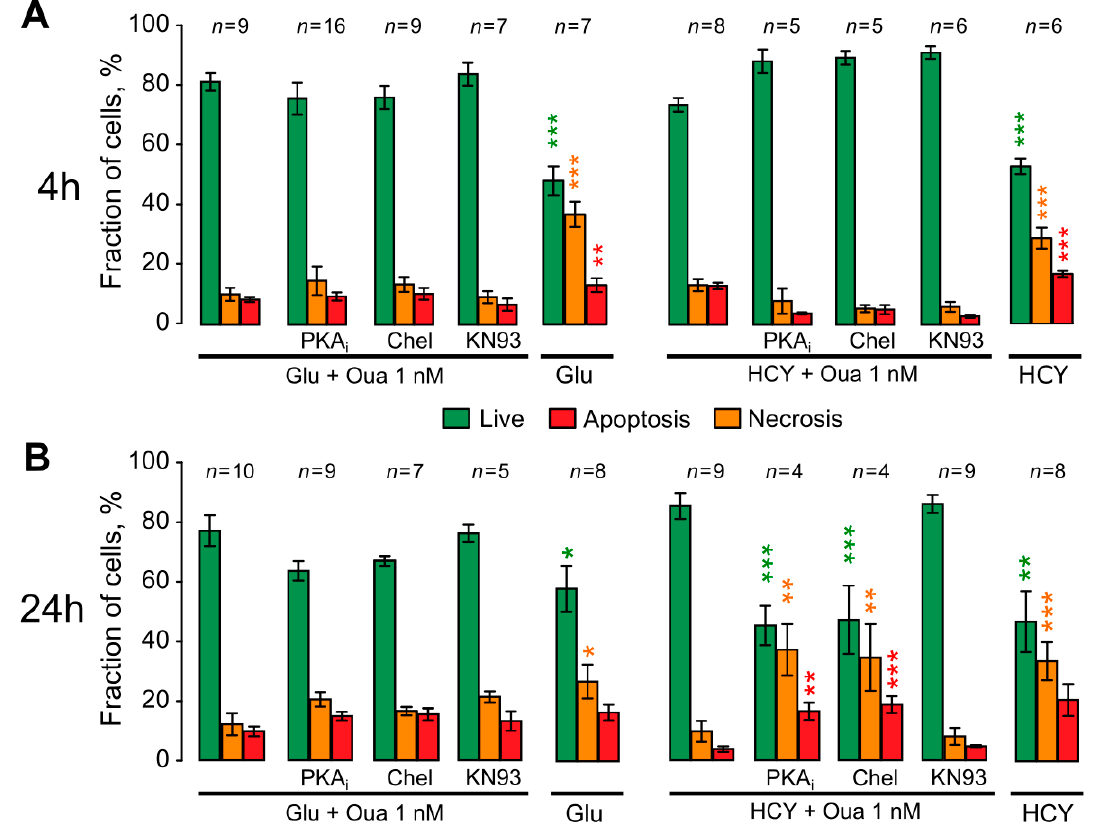
Figure 6. Effects of inhibitors of different protein kinases in ouabain-induced neuroprotection. The histograms quantitatively compare the data obtained in the presence of 100 μ M glutamate ( + 30 μ M glycine, Glu) or homocysteine ( + 30 μ M glycine, HCY) with 1 nM ouabain (Oua), and in combination with 0.6 μ M PKA inhibitor (PKA i ), 1 μ M PKC inhibitor chelerythrine (Chel), or 3 μ M CaMKII inhibitor (KN93) or during excitotoxic insults without Oua. Mean values ± SEM are plotted. Experimental conditions are indicated below the plot. Green columns represent percentages of live, red of necrotic, and orange of apoptotic neurons. Data were obtained in 4 h ( A ) and in 24 h ( B ) excitotoxic insults. *, **, ***—Data are significantly different from the values obtained in HCY with Oua (* p = 0.03; ** p = 0.009; *** p = 0.0001; ANOVA with Tukey’s post- hoc test). The number of experiments ( n ) for each group is indicated above the columns.